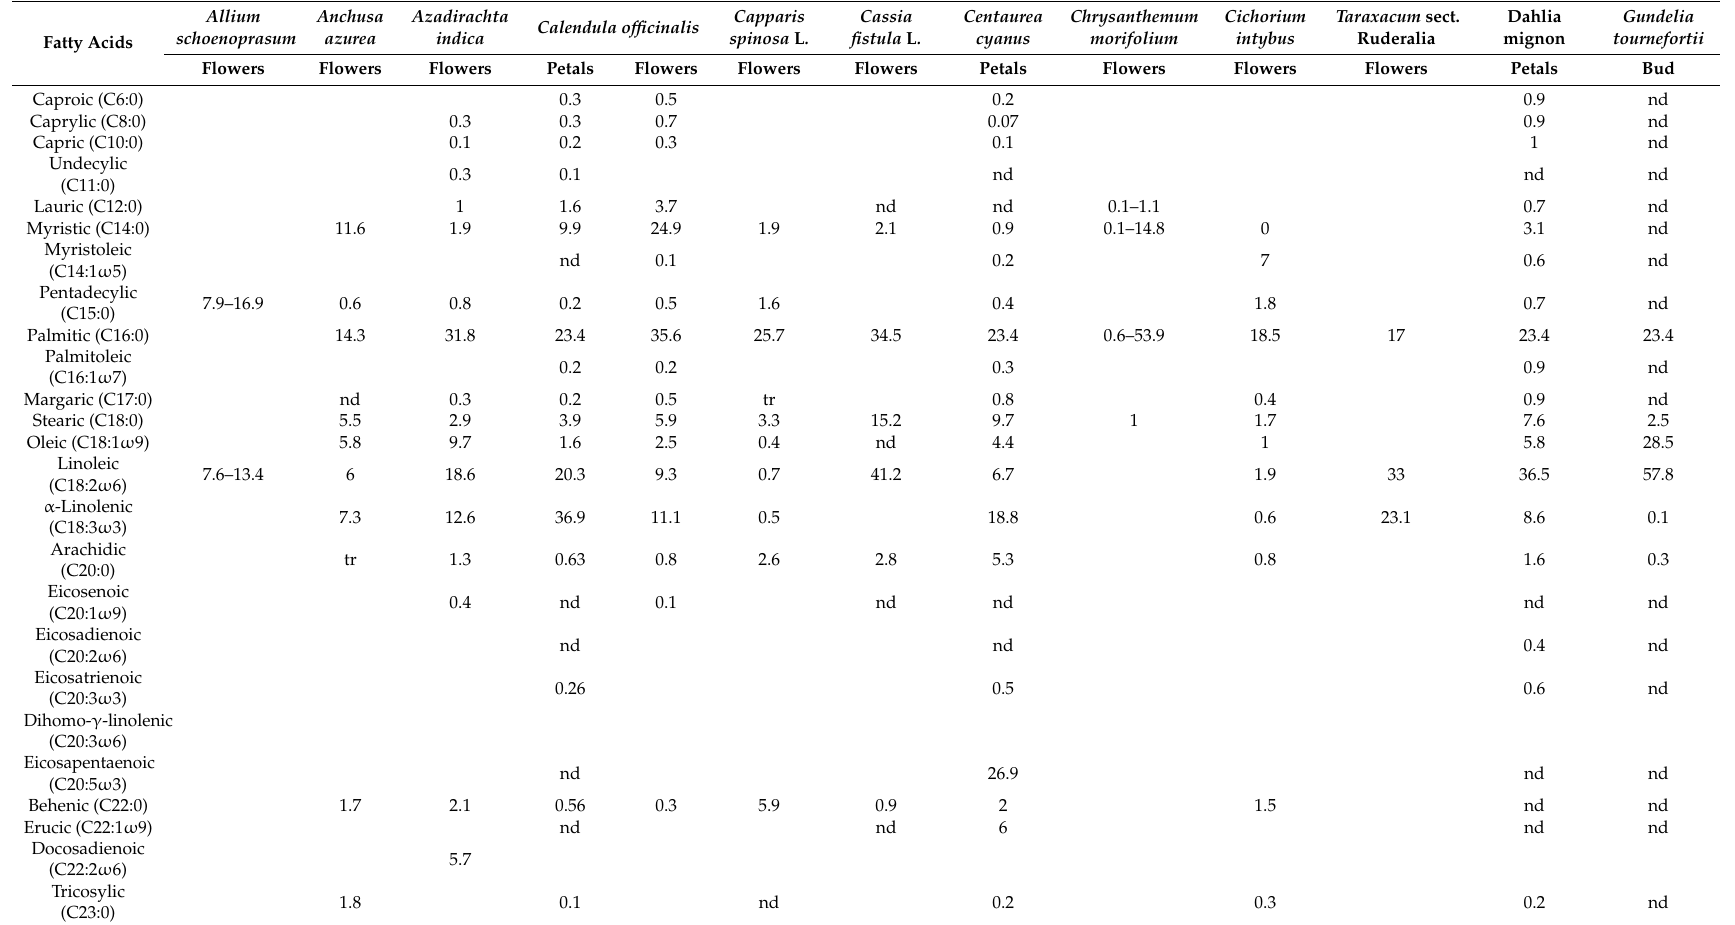
Table 2. Fatty acids (%) profile of some edible flowers mentioned in the